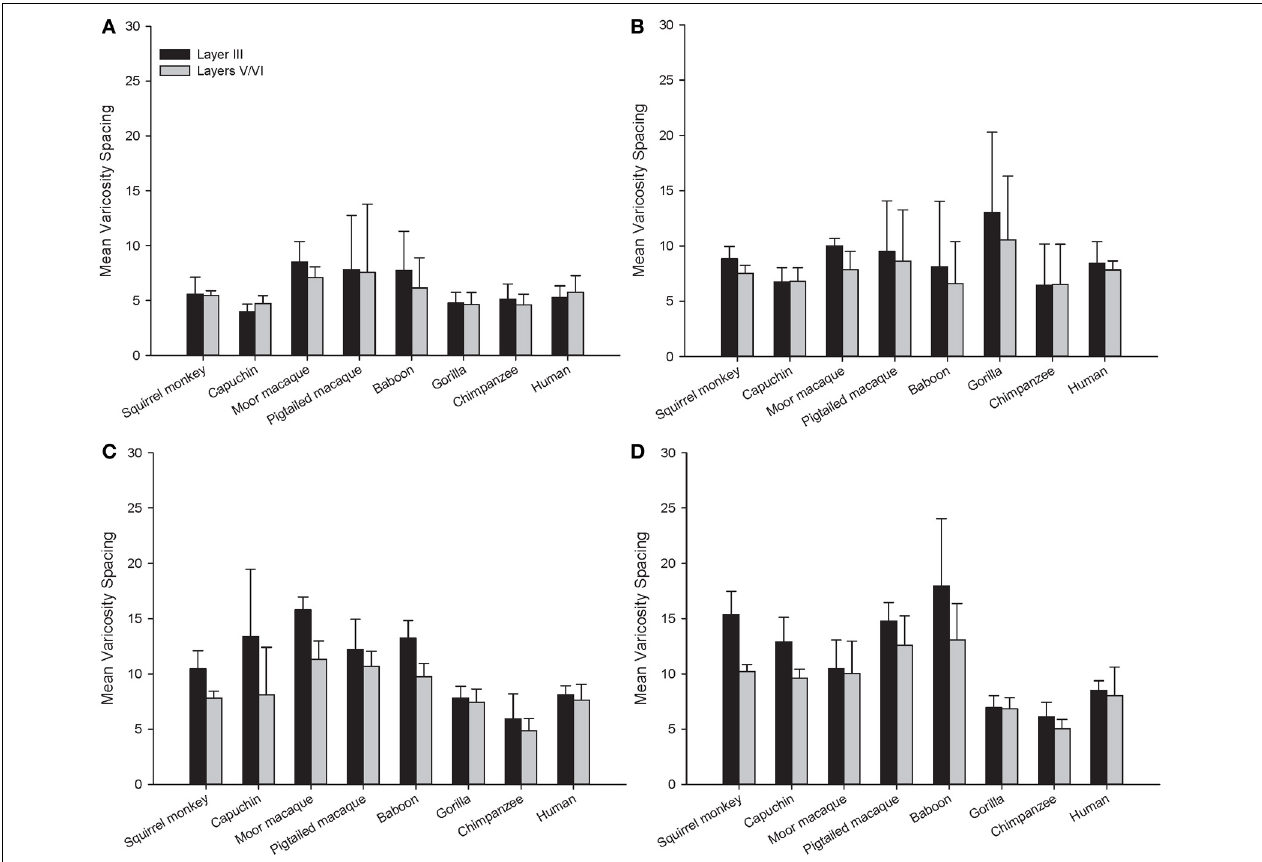
FIGURE 7 | Varicosity spacing in μ m for each species in (A) area 10, (B) area 24, (C) area 44, and (D) area 22. Means are shown by bars. Error bars indicate standard